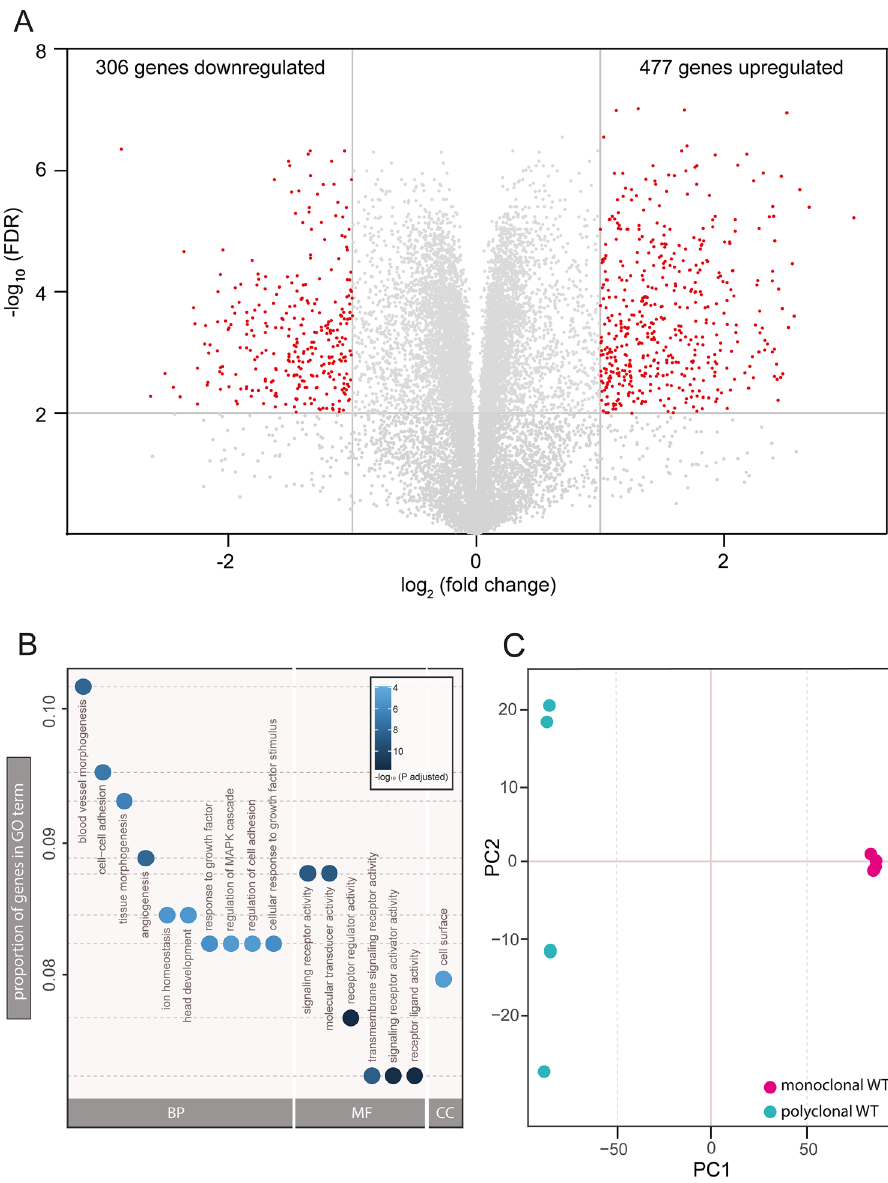
Figure 4. RNA sequencing analysis reveals altered expression levels between mono- and polyclonal wild-type cell lines and confirms heterogeneity of polyclonal cells. RNA was extracted from poly- and monoclonal (WT5) mIMCD-3 WT cell lines. RNA sequencing was performed for four technical replicates each. ( A ) Differential gene expression between poly- and monoclonal (WT5) cell lines are illustrated in a volcano plot. Threshold for false discovery rate (FDR) was set to log 10 ≥ 2. Threshold for fold change was set to log 2 ± 1. Grey dots represent genes which do not meet threshold criteria (FDR log 10 < 2 and/or log 2 (fold change) between ± 1). Red dots indicate significant changes in expression. 306 genes are significantly downregulated, 477 genes are significantly upregulated in monoclonal compared to polyclonal mIMCD-3 WT cell lines (adjusted p-value < 0.01). ( B ) Gene ontology (GO) term analysis shows most significant changes in expression levels of genes in dependence of gene ontology classification. Y-axis depicts proportion of genes in GO term analysis. Each dot represents distinct ontologies. Colour of dots represents significance of changes in expression levels between mono- and polyclonal WT-cells. Colour scheme depicts significance levels (− log 10 p-adjusted). BP biological process, MF molecular function, CC cellular components. ( C ) Principal component (PC) analysis shows variability between sequencing replicates. Monoclonal sequencing replicates cluster together in contrast to polyclonal sequencing replicates showing a heterogeneous